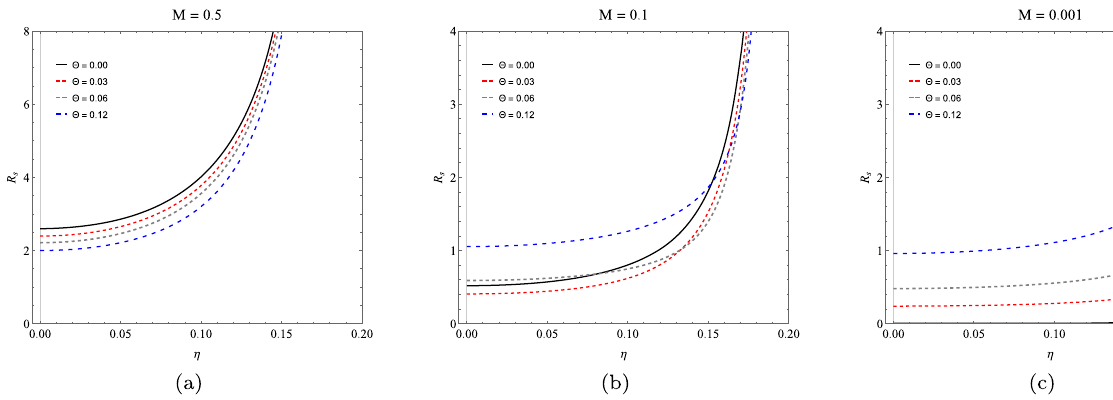
Fig. 12 Influence of the (cid:11) and η parameters on the shadow radius